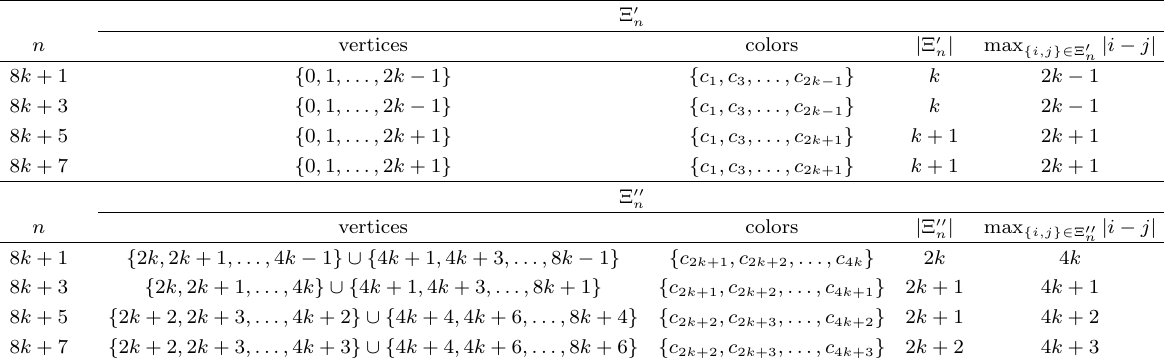
and Ξ (cid:48)(cid:48) n n